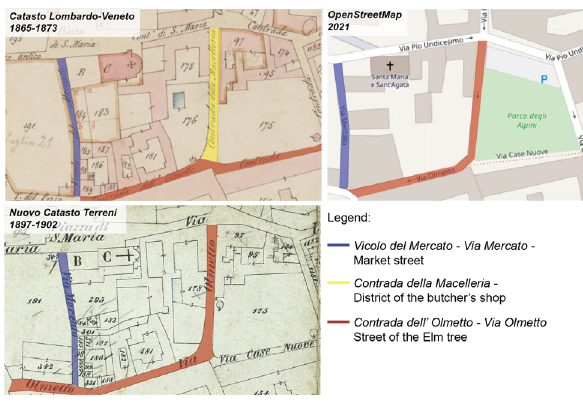
Figure 4. Example of streets’ names in Desio and their change through time. The presence of different services and events, religious buildings or vegetation determined the name of a street (surface highlighted for better visualisation). Source: ASMi, OpenStreetMap, authors